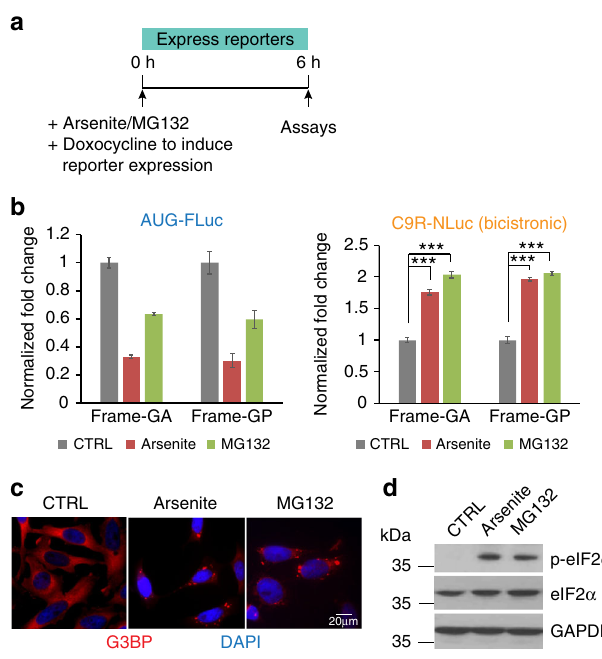
Fig. 2 Cap-independent RAN translation is upregulated upon stress. a Schematic timeline of stress stimuli and induction of luciferase reporters in HeLa Flp-In cells. b Expression of bicistronic luciferase reporters was induced by doxycycline for 6 h in HeLa Flip-In cells. At the same time, cells were treated with arsenite or MG132 stimuli. Relative expression of AUG- FLuc and C9R-NLuc reporters was compared with no stress control. The luciferase signals were normalized to the total protein amount. Data are mean ± SEM from three biological replicates. *** P < 0.0005, two-tailed t- test. c Stress granules were detected with G3BP immuno fl uorescence in reporter cells treated with arsenite and MG132. d Immunoblotting using antibody recognizing phospho-eIF2 α at the Ser51 site showed the upregulation under stress. GAPDH and total eIF2 α were blotted as